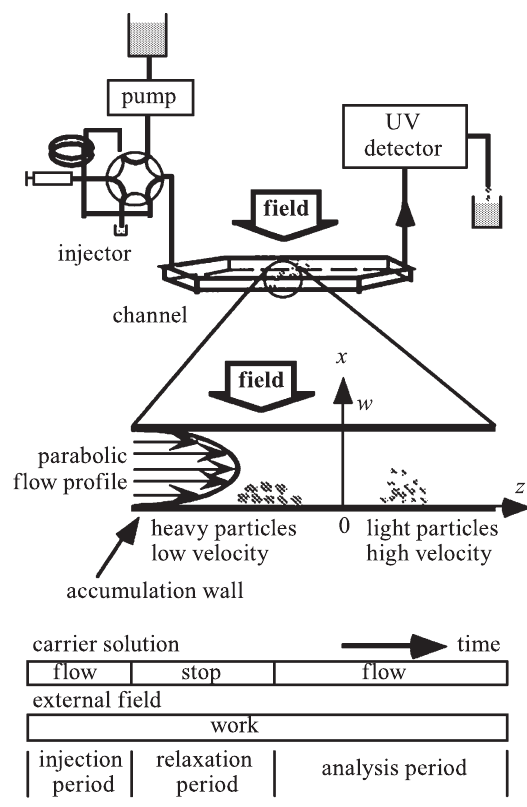
Fig. 1 Schematic of FFF and the principle of particle separa- tion (Mori Y.,